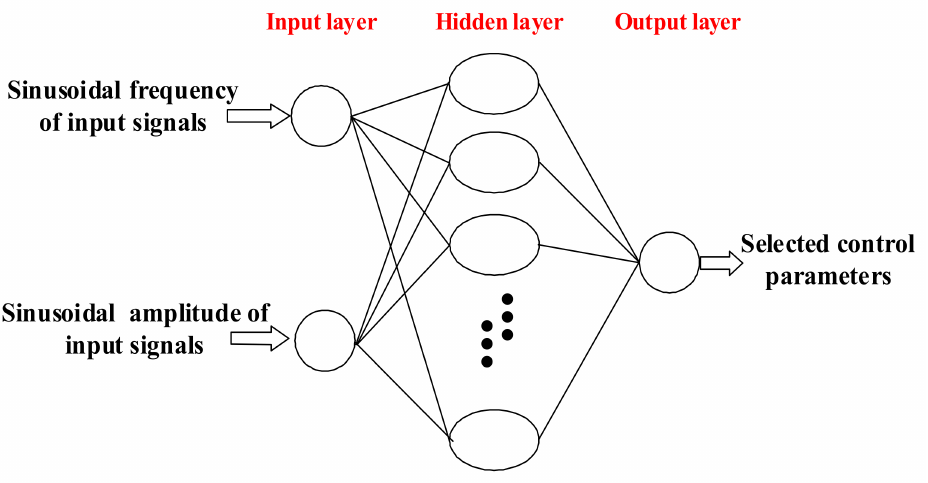
Figure 9. Overall structure of neural network 2.